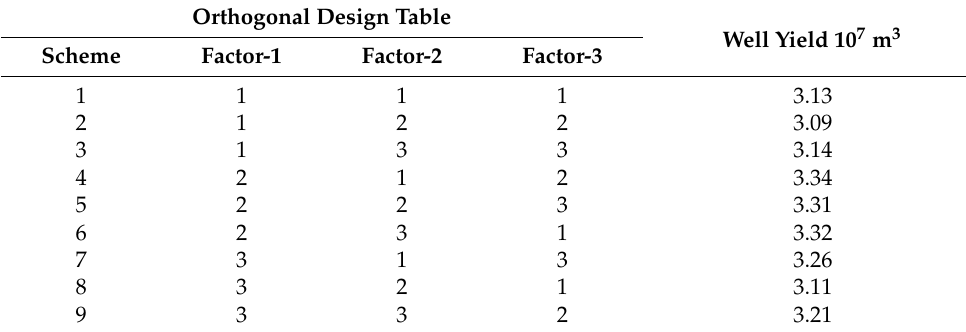
Table 7 is the yield analysis table of the different schemes of deviated wells. Table 7. Yield analysis table for different schemes of deviated well. Orthogonal Design